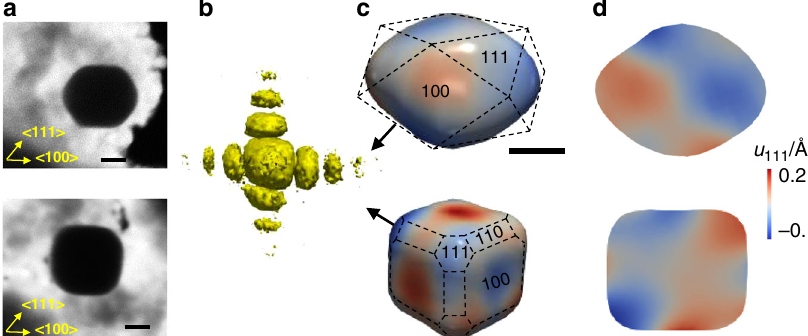
Fig. 1 Morphology of gold nanocrystals at room temperature. a Scanning electron microscopy images of the dried supported gold crystals, showing well- de fi ned cuboctahedric (top) and cubic (bottom) shapes. b 3D diffraction pattern obtained by rocking scans around the (111) Bragg peak of the cube. c 3D displacement fi eld along the [111] direction with the black vector representing the q 111 scattering vector. The facets orientations are shown. d Cross-section views of the internal displacement along the [111] direction. Scale bars, 30